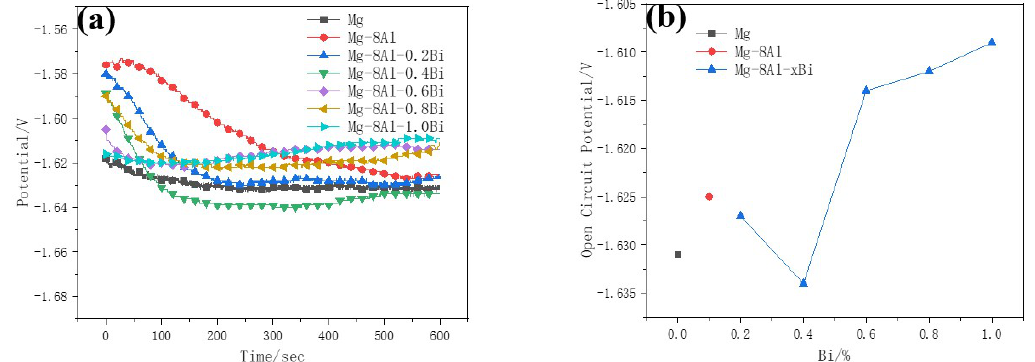
Figure 2. ( a ) Open circuit potential–time curves of Mg–8%Al–xBi alloys; ( b ) Open circuit potential–Bi content curves measured in 3.5% NaCl solution. content curves measured in 3.5% NaCl